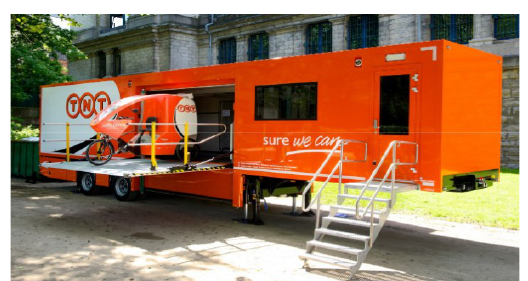
Figure 2. TNT Express Mobile Depot, adopted